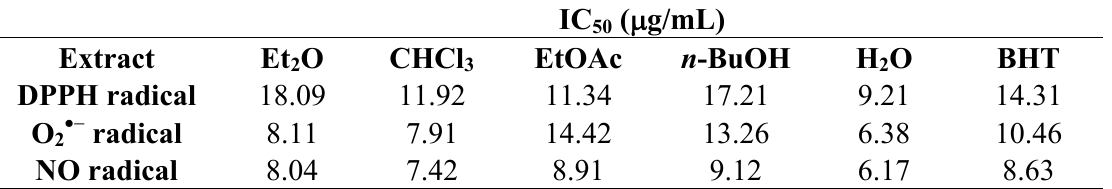
values ( μ g/mL) of the neutralization of DPPH, O Table 2. IC 50 melissophyllum